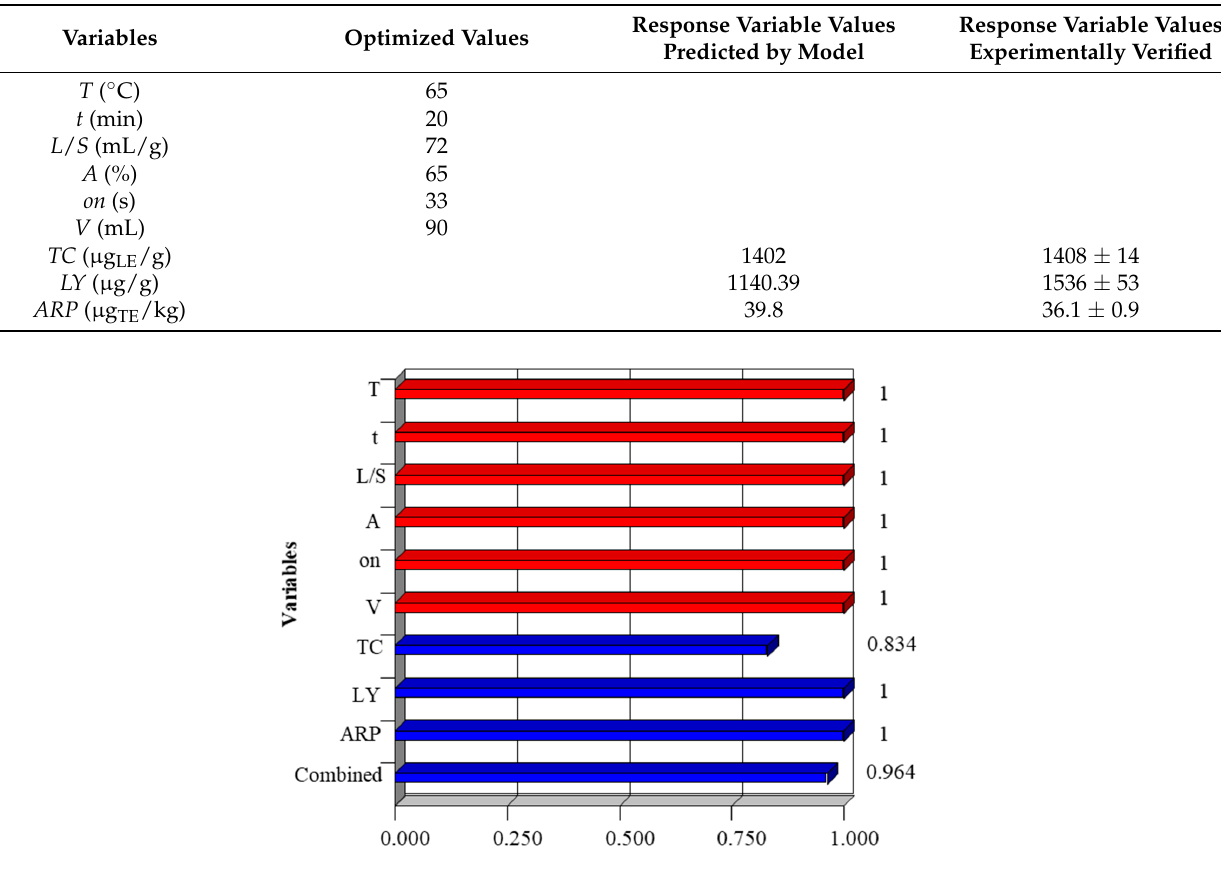
Table 5. Results of numerical optimization and experimental verification.